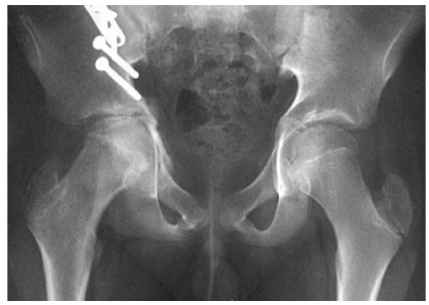
Figure 5: Terminal right hip